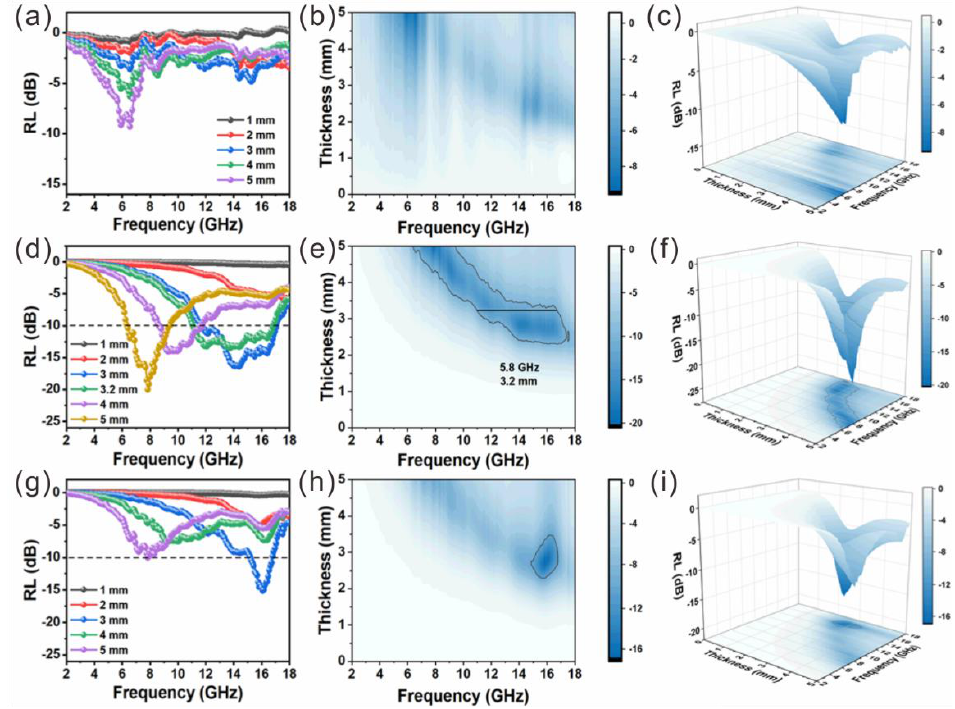
Figure 7. A 1D plot, 2D map, and 3D diagram of RL value as a function of frequency and thickness: ( a − c ) S1, ( d − f ) S2, and ( g − i ) S3. ( a – c ) S1, ( d – f ) S2, and ( g – i )